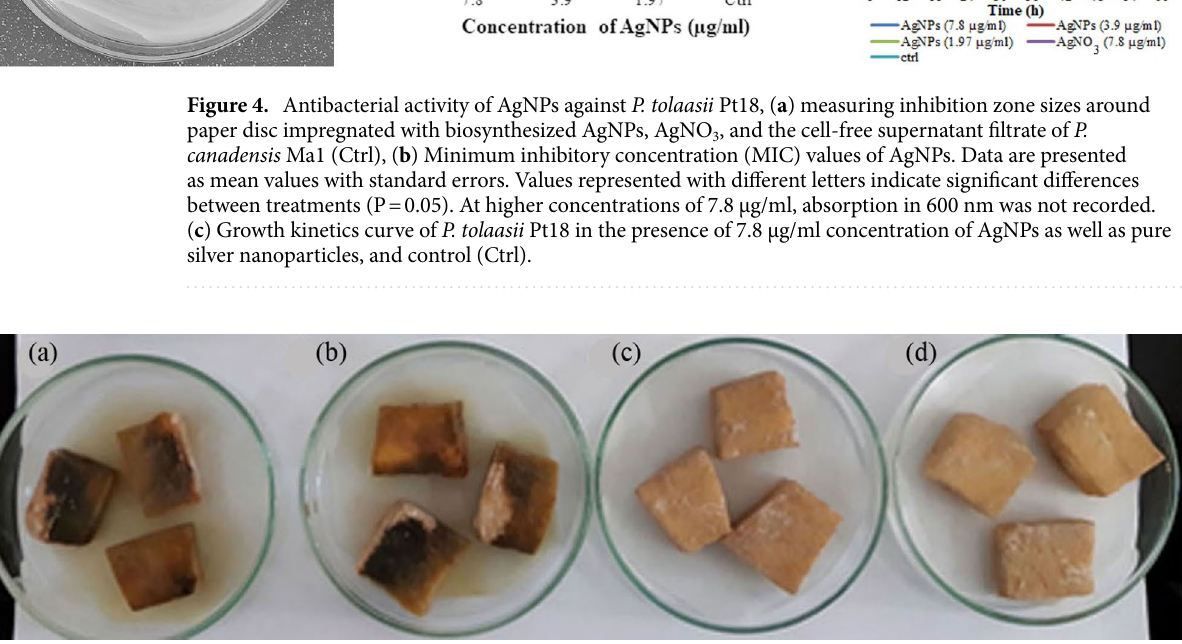
Figure 5. Effect of AgNPs on detoxification of tolaasin produced by Pseudomonas tolaasii Pt18 in potato tuber slices inoculated with ( a ) PSB-Tol, ( b ) PSB-Tol + AgNO 3 , ( c ) PSB-Tol + AgNPs, and ( d ) AgNPs.